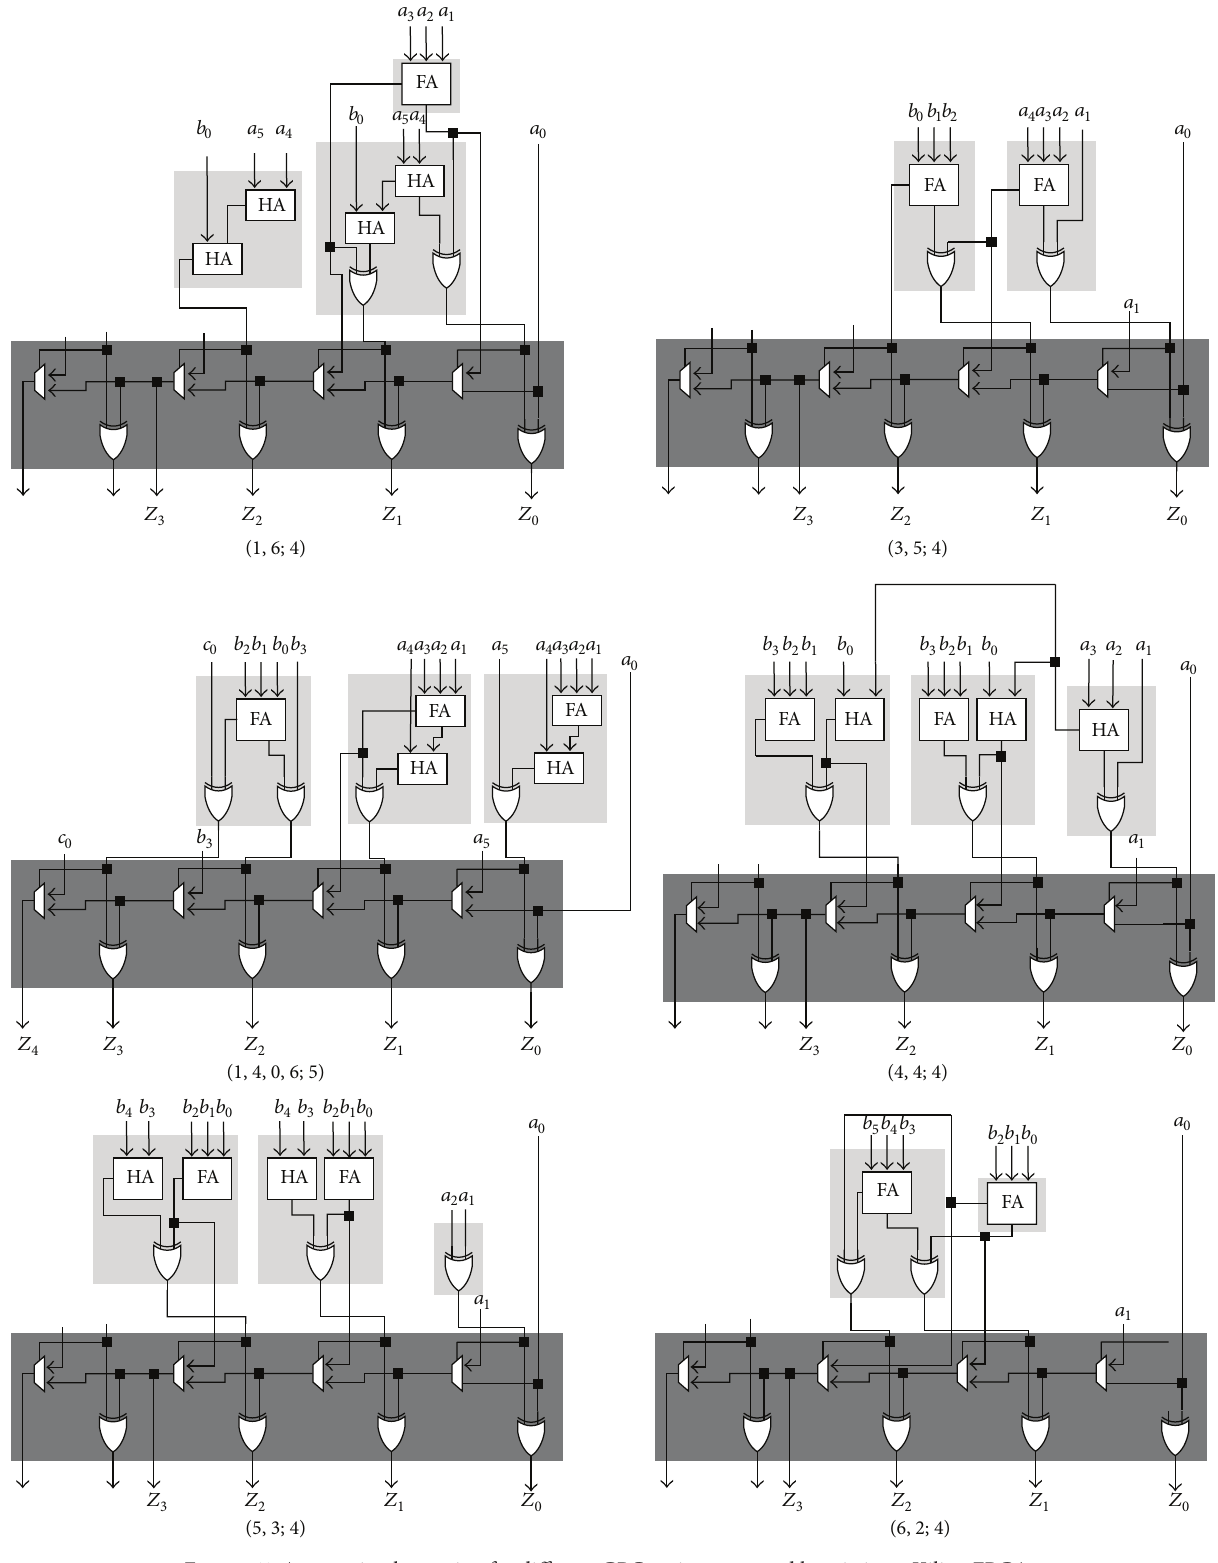
Figure 11: Area optimal mapping for different GPCs using proposed heuristic on Xilinx